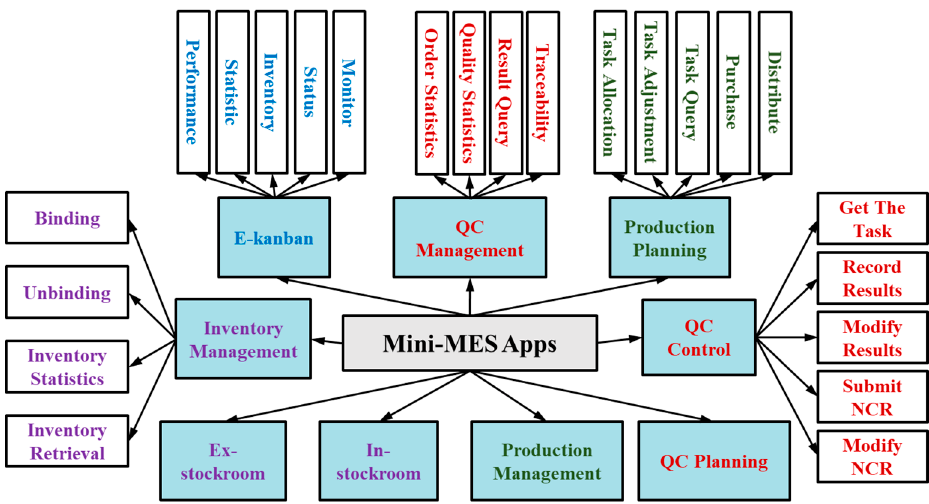
Figure 10. Function decomposition and corresponding M 2 ES Apps.